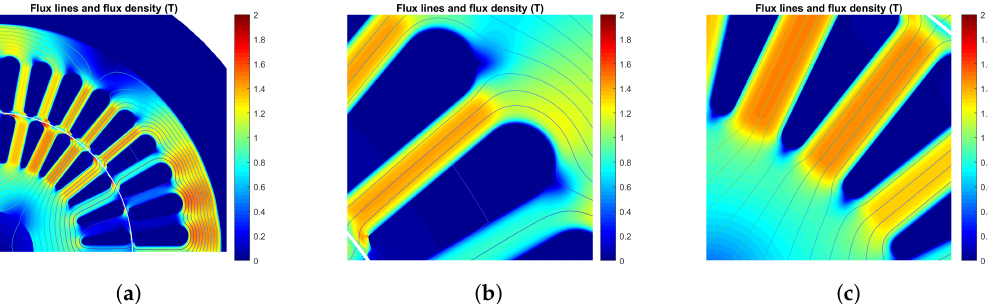
Figure 8. Flux density distribution of 1/4 section of the 2.2 kW induction motor is shown in ( a ). The distribution around ( b ) stator slots and ( c ) rotor slots are portrayed.